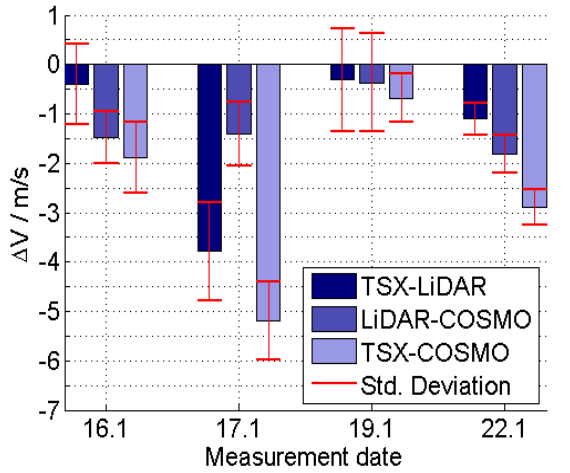
Figure 8. Comparison of absolute wind speeds obtained by TerraSAR-X, LiDAR and COSMO-DE. Mean difference and standard deviation are plotted